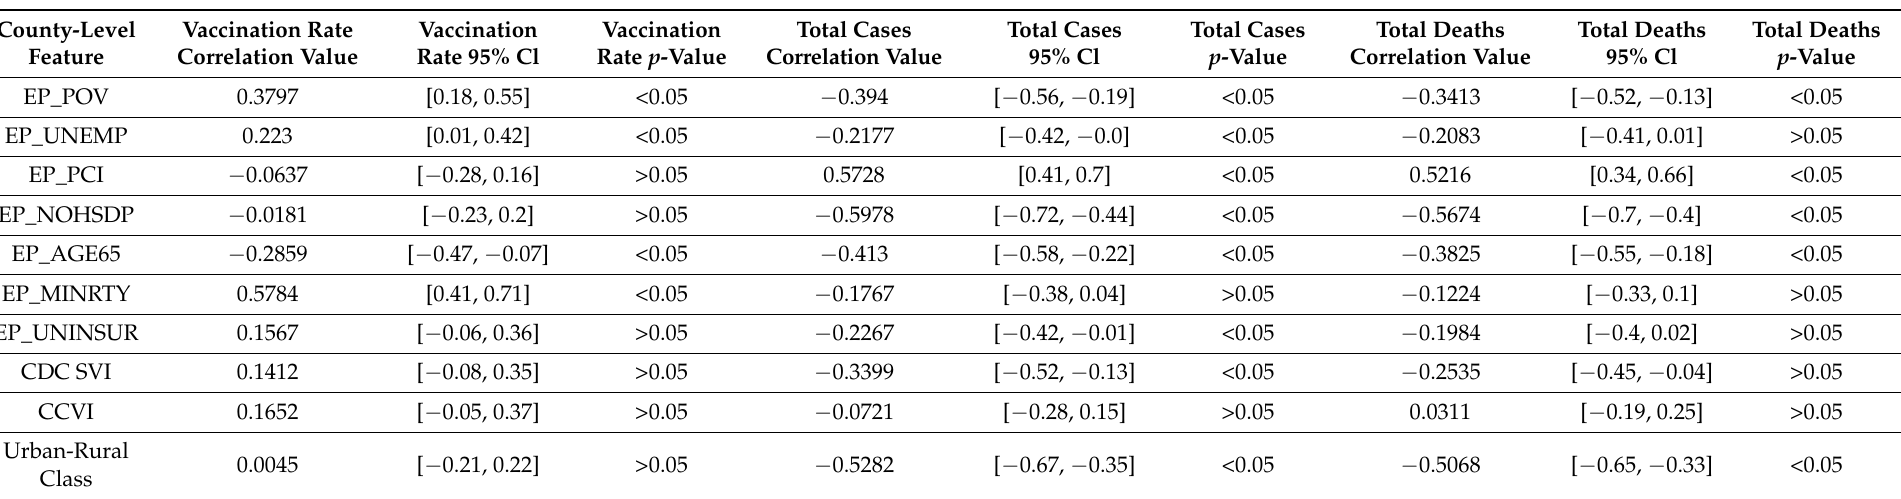
Table 1. Pearson Correlation Value of COVID-19 Target Variables compared to SDOH Feature